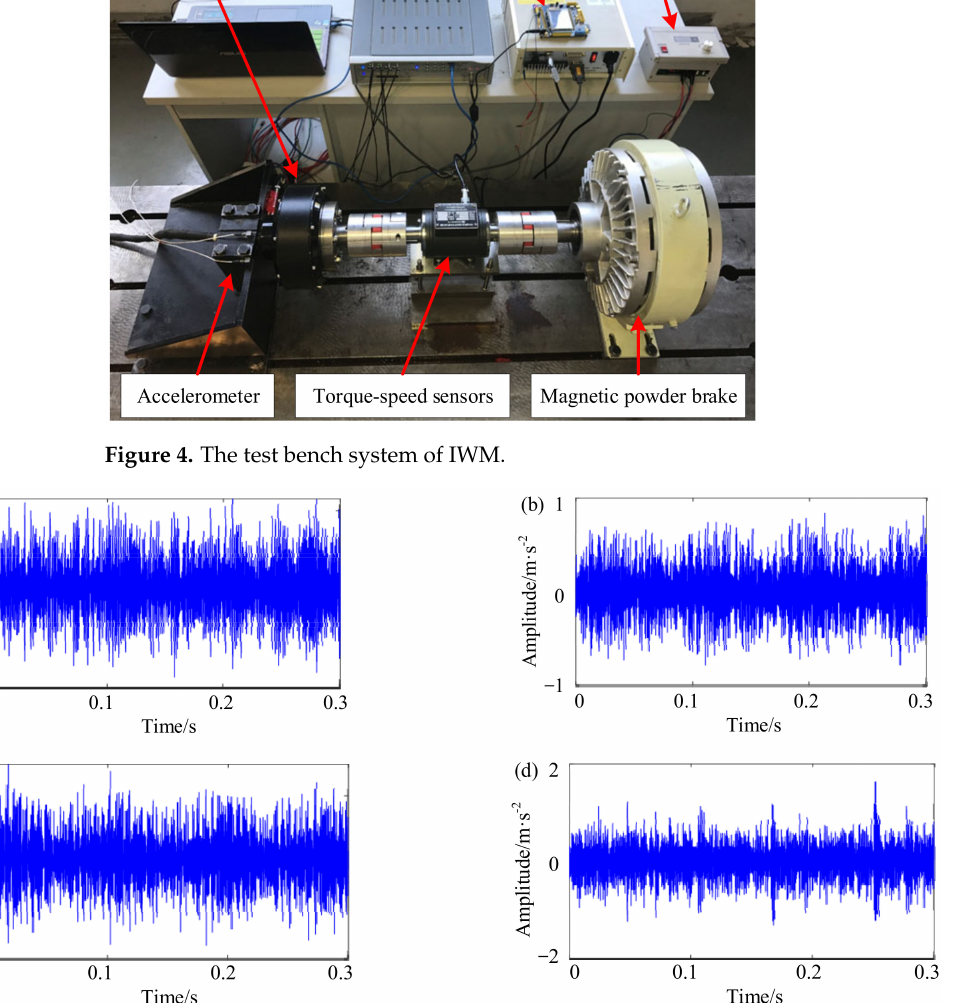
Figure 5. Vibration signals of four IWMs at the rotating speed of 700 rpm and load torque of 30 N · m: ( a ) State 1—normal state; ( b ) State 2—rolling element defect; ( c ) State 3—inner ring defect; ( d ) State 4—outer ring